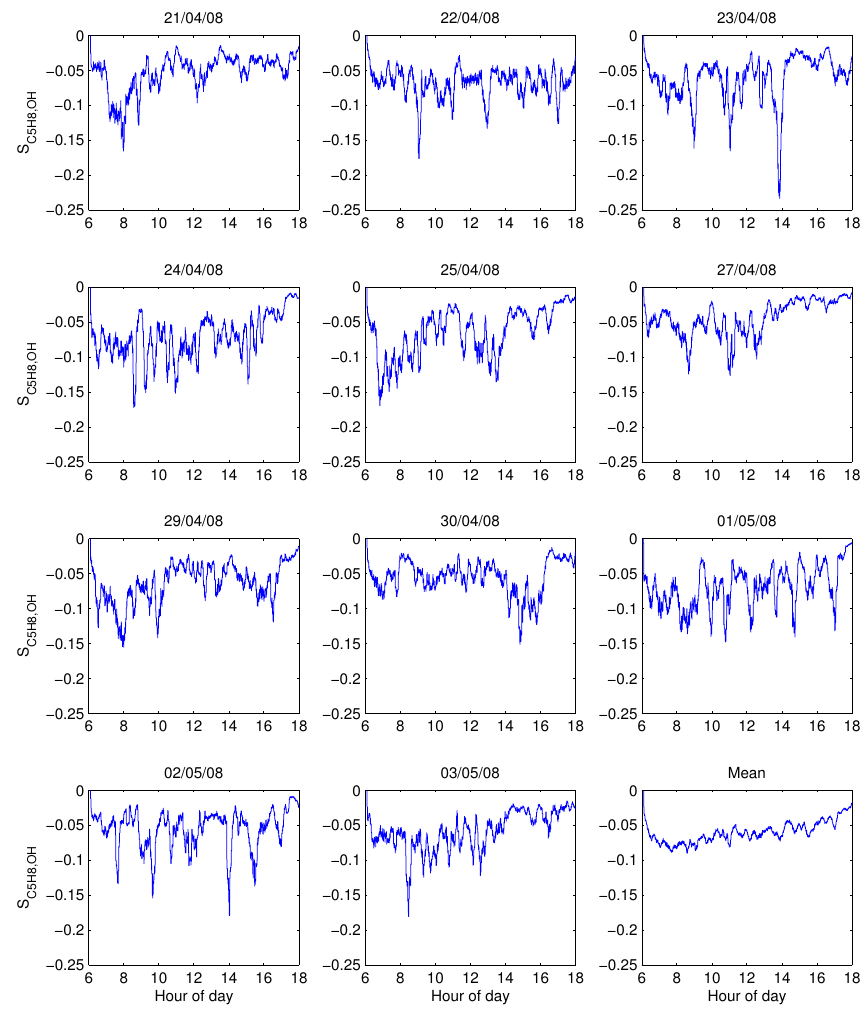
Fig. 5. Model calculated intensity of segregation for t s =10min, showing each day during OP3-1 and the overall mean. Note that results before 10:00LT are not representative of the boundary layer as a